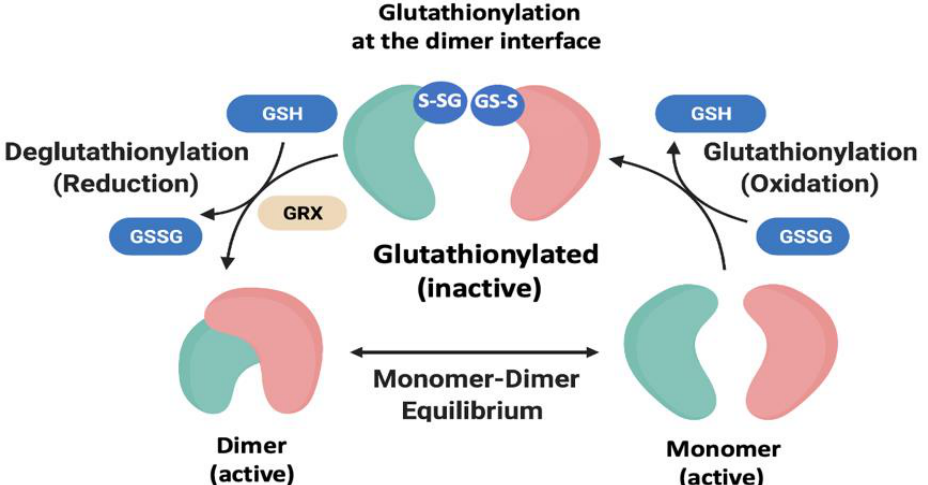
Figure 3. Model depicting the M pro active dimer in equilibrium with its inactive monomers. Oxidized glutathione can glutathionylate Cys300 leading to inhibition of dimerization and activity. This process can be reversed with reducing agents or with Grx leading to the fully active dimer form.